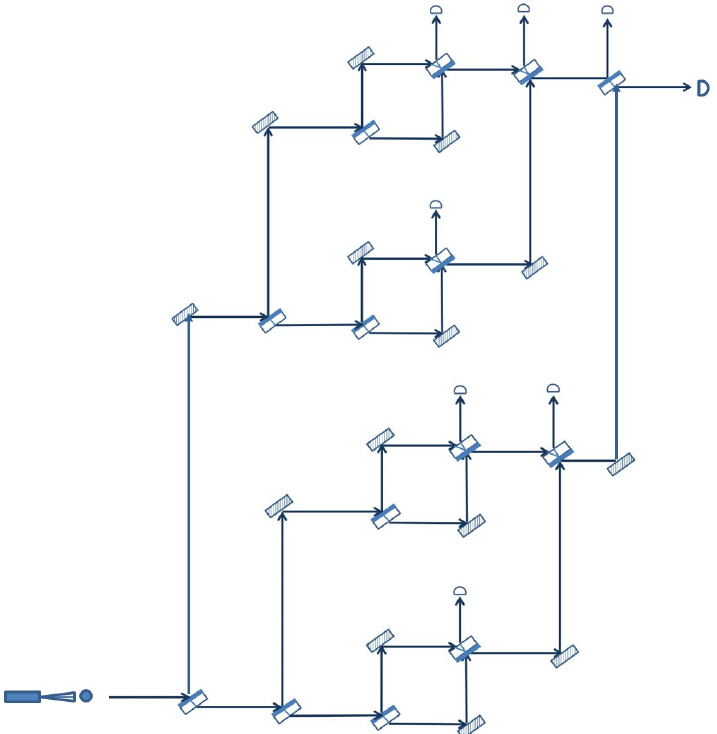
Figure 4. Quantum sensor network obtained recursively from two extended quantum